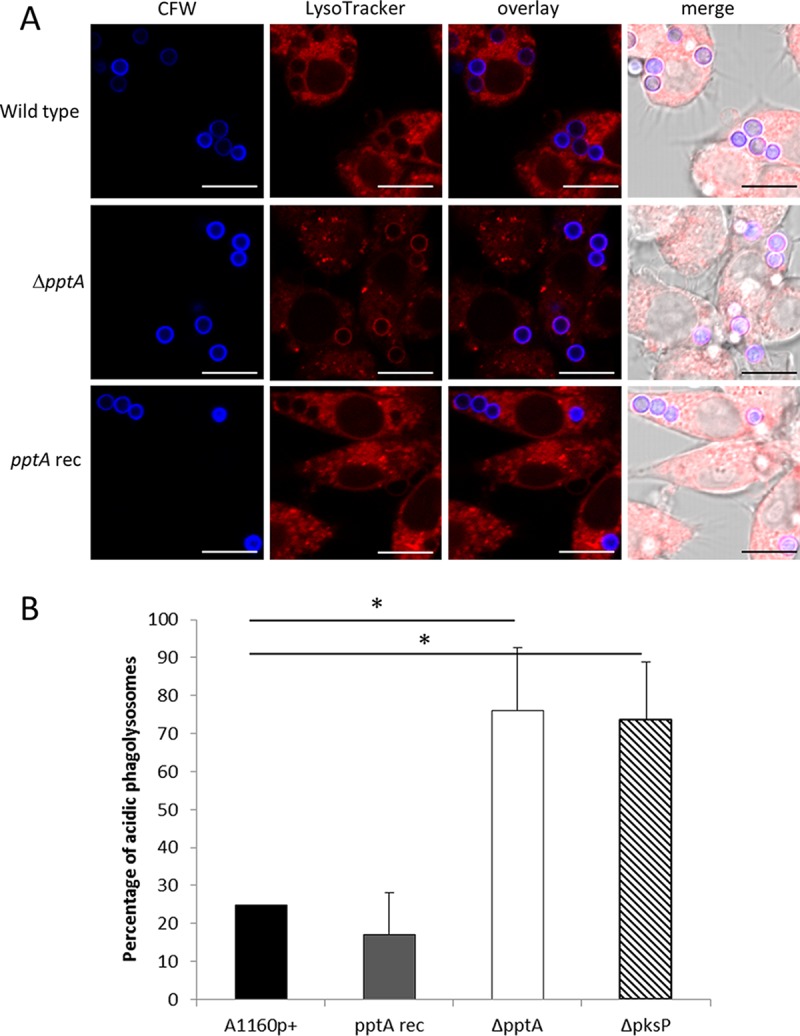
Detection of conidia in acidified compartments after phagocytosis by RAW264.7 macrophages. (A) Calcofluor white (CFW)-labeled conidia were intracellularly colocalized by using LysoTracker Red-DND99 in RAW 264.7 macrophages, and the ratio of acidified phagolysosomes was determined after 2 h of coincubation with an MOI of 2. (B) The percentages of conidia in acidic phagolysosomes. Data represent mean results and SDs (error bars) of three independent experiments.